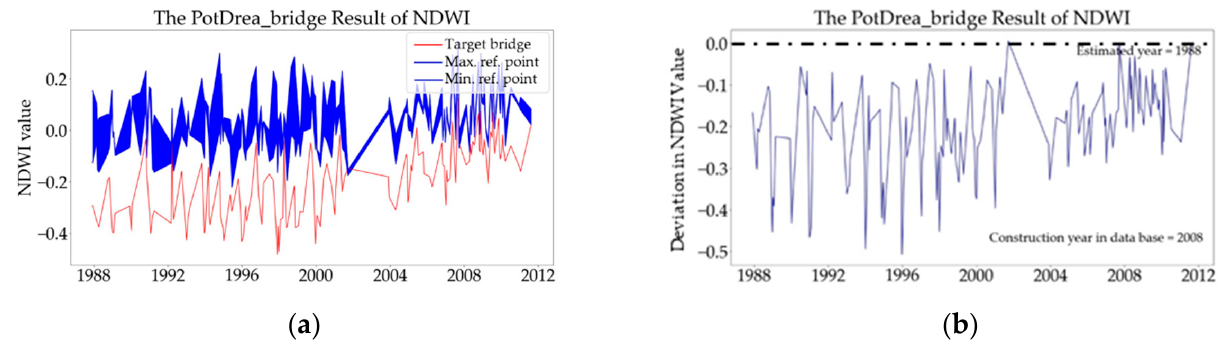
Figure 11. ( a ) Variation of NDWI index value of the target bridge (point) and the reference points for the Pot Drea bridge; ( b ) re-visualization of ( a ) showing difference between NDWI value of target and that of the closest reference point.